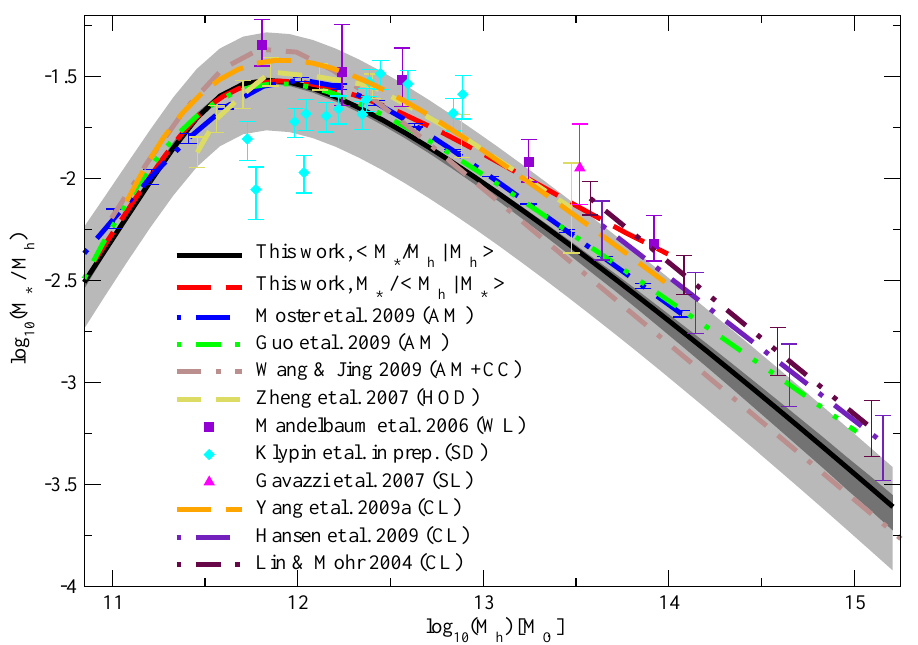
Figure 2. Figure from Behroozi et al. [24]. The figure shows different determinations of the galaxy stellar-to-halo mass relation at z = 0.1. These include results based on abundance matching [25,26]; abundance matching plus clustering constraints (this approach uses a parametrization of the stellar mass-halo mass relation and attempts to reproduce simultaneously the stellar mass function and clustering data [27]); HOD modeling [28]; direct measurements from weak lensing [29]; satellite dynamics (Klypin et al.); strong lensing [30]; and clusters selected from SDSSspectroscopic data [31], SDSS photometric data (the maxBCGsample [32]), and X-ray selected clusters [33]. The black solid lines show results by Behroozi et al. [24], also based on abundance matching. Dark grey shading indicates statistical and sample variance errors; light grey shading includes systematic errors. The red line shows the same results averaged over stellar mass instead of halo